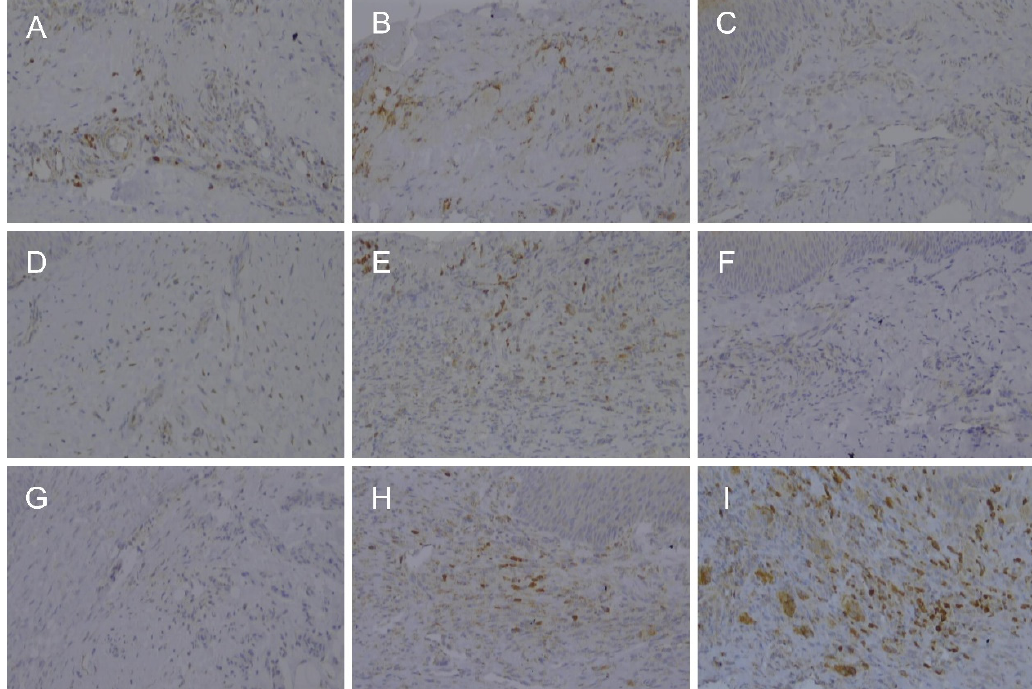
Figure 6. Expression of iNOS in the rat palate tissue 3 days after 3 days ( A – C ), 7 days ( D – F ), and 14 days ( G – I ). Scalpel ( A , D , G ), laser A ( B , E , H ), and laser B ( C , F , I ).